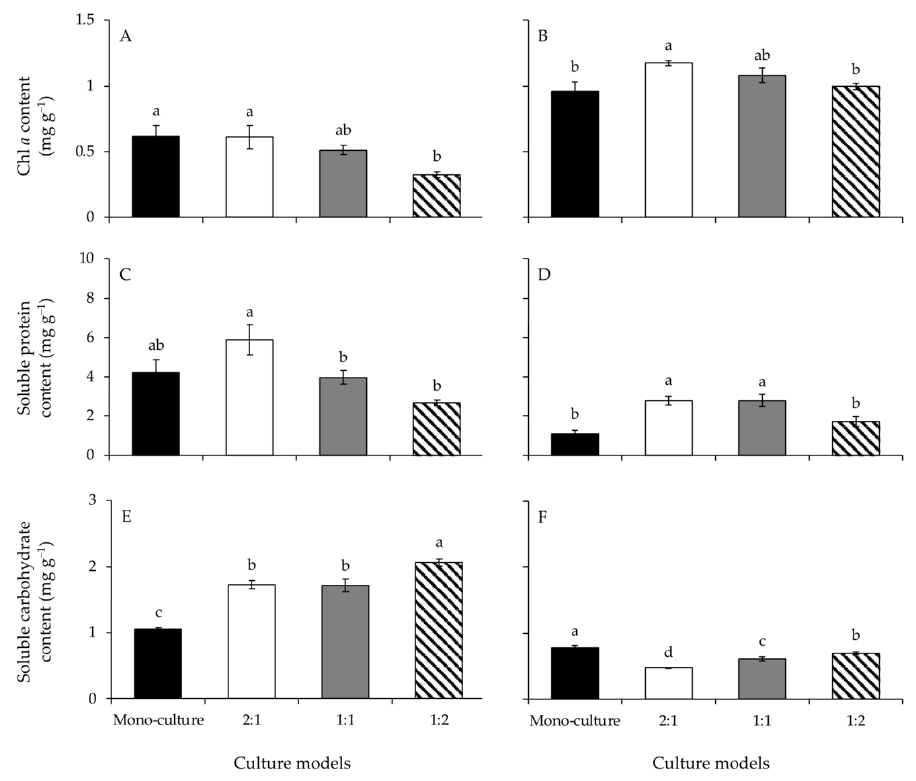
Figure 4. The contents of Chl a , soluble protein, and soluble carbohydrate of Gracilariopsis lemaneiformis ( A , C , E ) and Sargassum horneri ( B , D , F ) cultured for twelve days at mono-culture and co-culture with biomass density ratios of 2:1, 1:1, and 1:2. Different lowercase letters represent significant differences ( p < 0.05) among culture models.